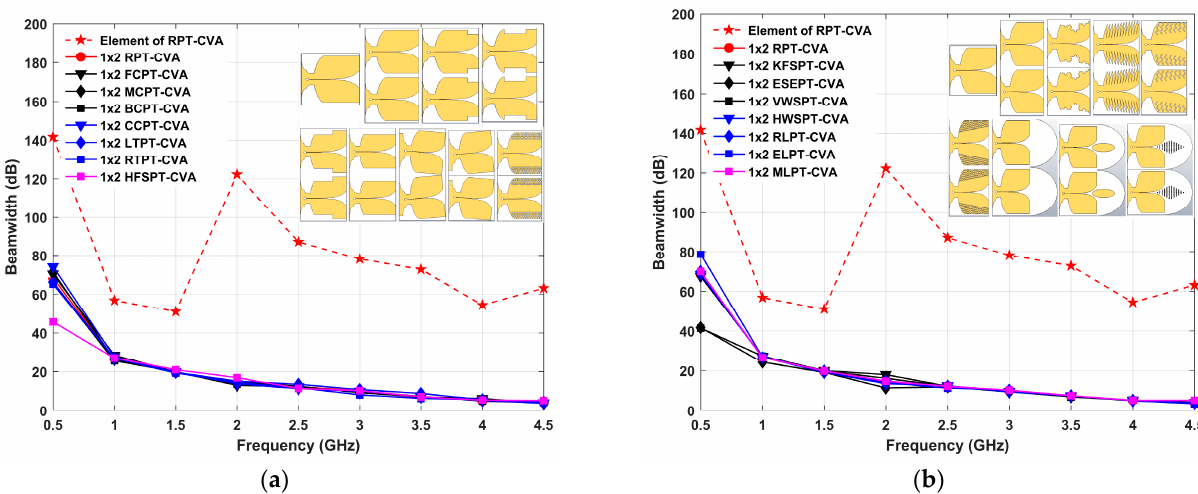
Figure 10. Beamwidth of ( a ). Element and 1 × 2 Regular Palm Tree (RPT-CVA), 1 × 2 Front Cut Palm Tree (FCPT-CVA), 1 × 2 Middle Cut Palm Tree (MCPT-CVA), 1 × 2 Back Cut Palm Tree (BCPT-CVA), 1 × 2 Complete Cut Palm Tree (CCPT-CVA), 1 × 2 Left Tilt Palm Tree (LTPT-CVA), 1 × 2 Right Tilt Palm Tree (RTPT-CVA), 1 × 2 Hilbert Fractal Structure Palm Tree (HFSPT-CVA), and ( b ). Element and 1 × 2 Regular Palm Tree (RPT-CVA), 1 × 2 Koch Fractal Structure Palm Tree (KFSPT-CVA), 1 × 2 Exponential Slot Edge Palm Tree (ESEPT-CVA), 1 × 2 Vertical Wave Structure Palm Tree (VWSPT-CVA), 1 × 2 Horizontale Wave Structure Palm Tree (HWSPT-CVA), 1 × 2 Regular Lens Palm Tree (RLPT-CVA), 1 × 2 Elips Lens Palm Tree (ELPT-CVA), and 1 × 2 Metamaterial Lens Palm Tree